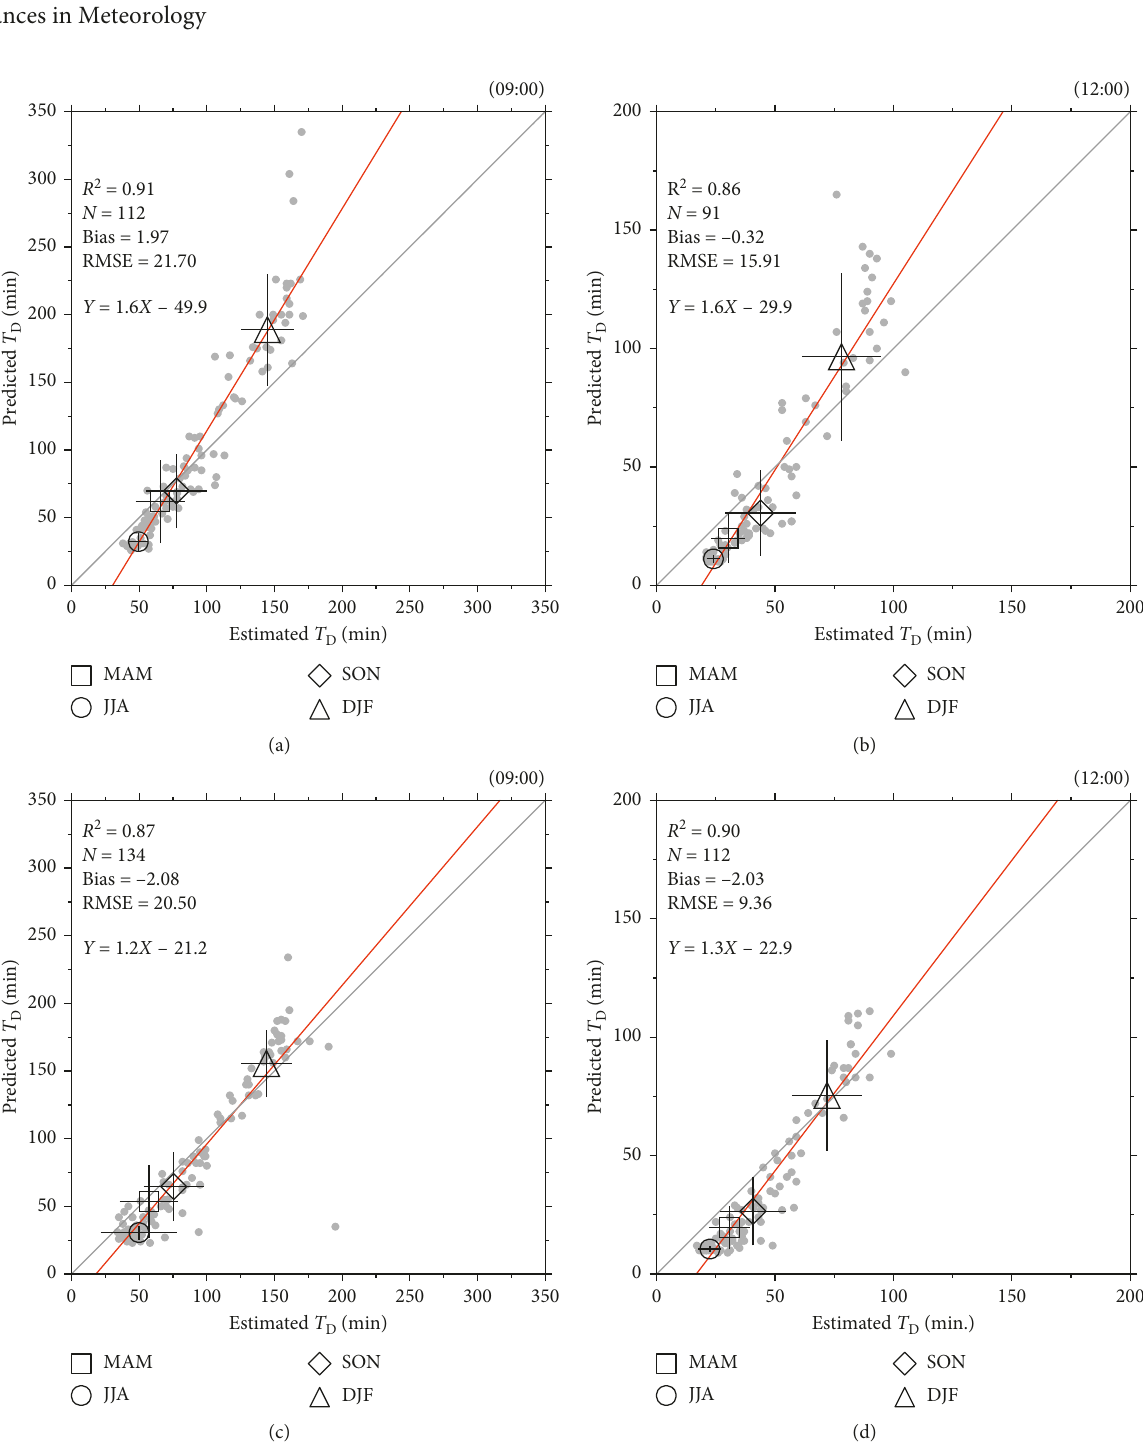
D ) and ( D +1) forecast simulation